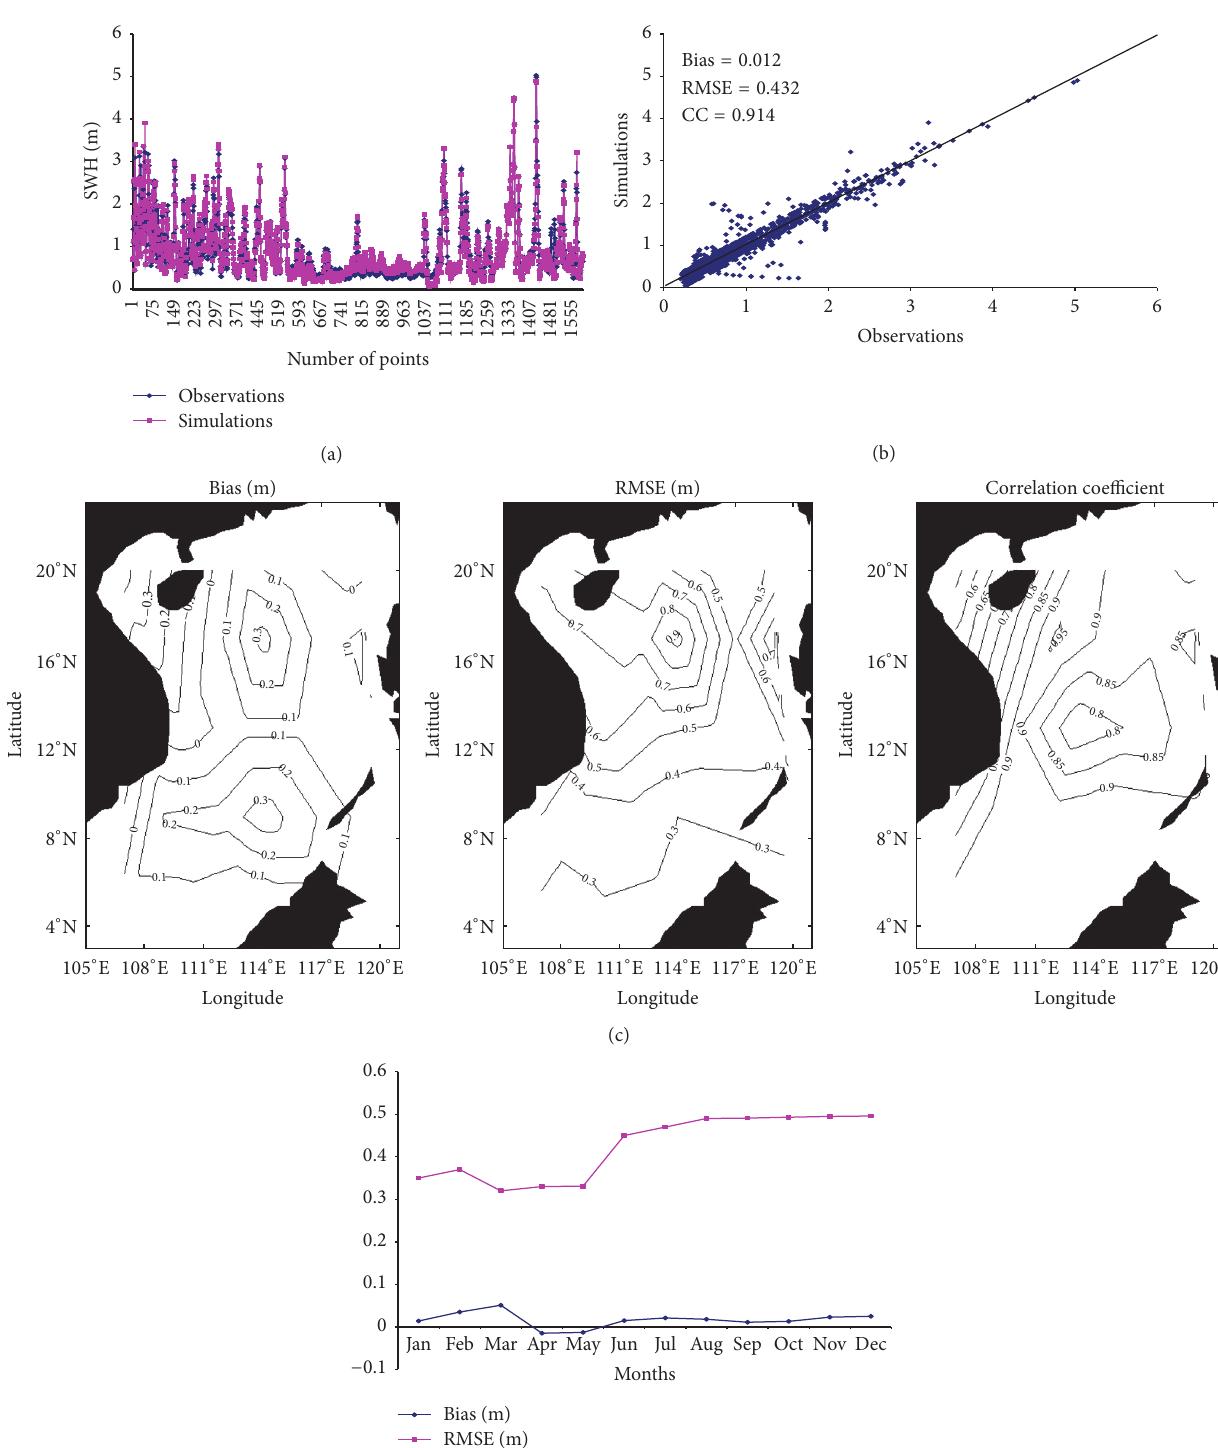
Figure 4: (a) Time series of the wave model data against Topex/Poseidon data for the SWH; on the 𝑥 -axis is the number of data points. (b) Scatter plot of the wave model data against Topex/Poseidon data for the SWH. (c) Distributions of SWH: Bias, RMSE error, and correlation coefficient between WW3 and Topex/Poseidon data. (d) Temporal error variability of the Bias and RMSE between WW3 and Topex/Poseidon data for all the crossover